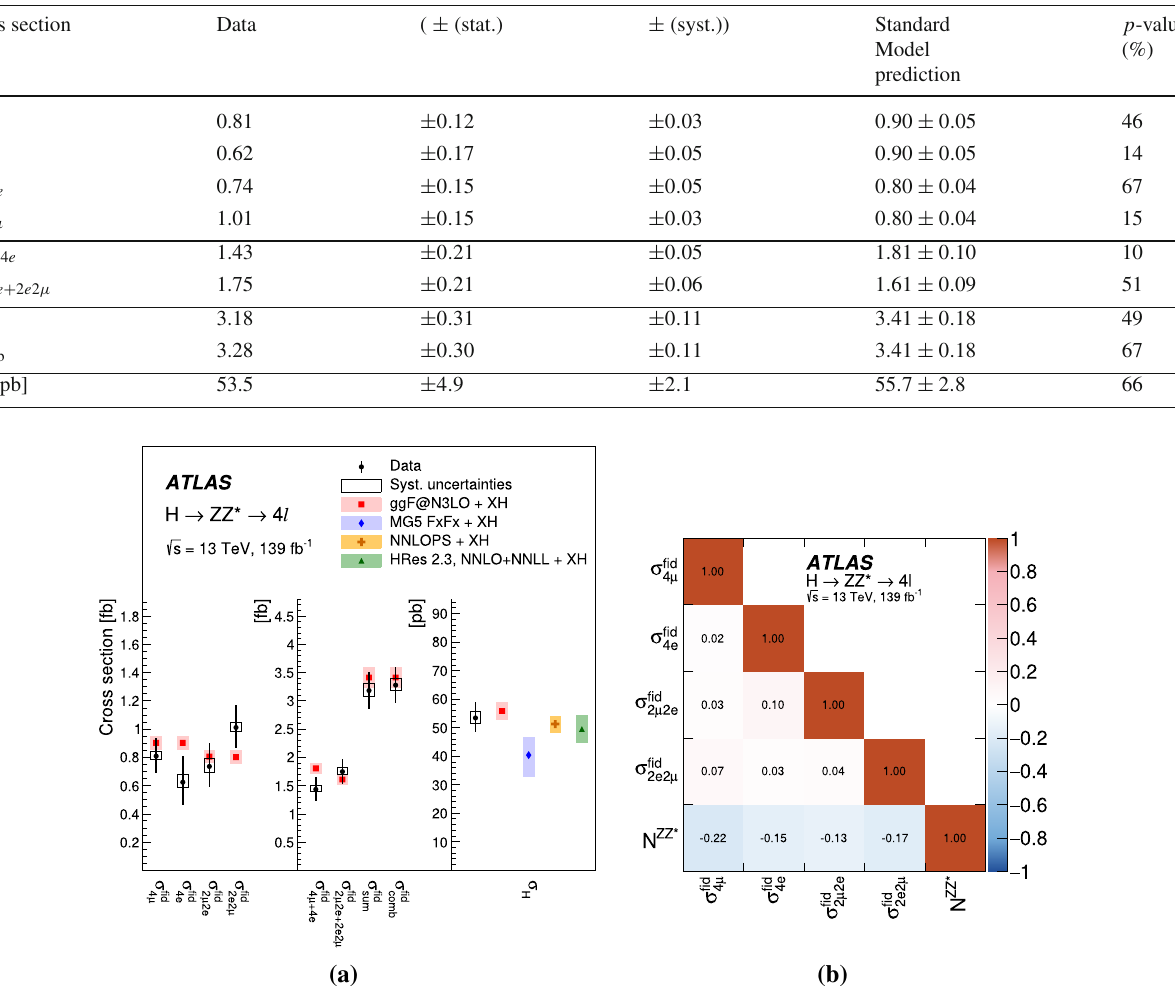
Table 7 The fiducial and total cross sections of Higgs boson produc- tion measured in the 4 (cid:3) final state. The fiducial cross sections are given separately for each decay final state, and for same- and different-flavour decays.Theinclusivefiducialcrosssectionismeasuredasthesumofall final states ( σ sum ), as well as by combining the per-final-state measure- ments assuming SM Z Z ∗ → 4 (cid:3) relative branching ratios ( σ comb ). For the total cross section ( σ tot ), the Higgs boson branching ratio at m H = 125 GeV is assumed. The total SM prediction is accurate to N 3 LO in